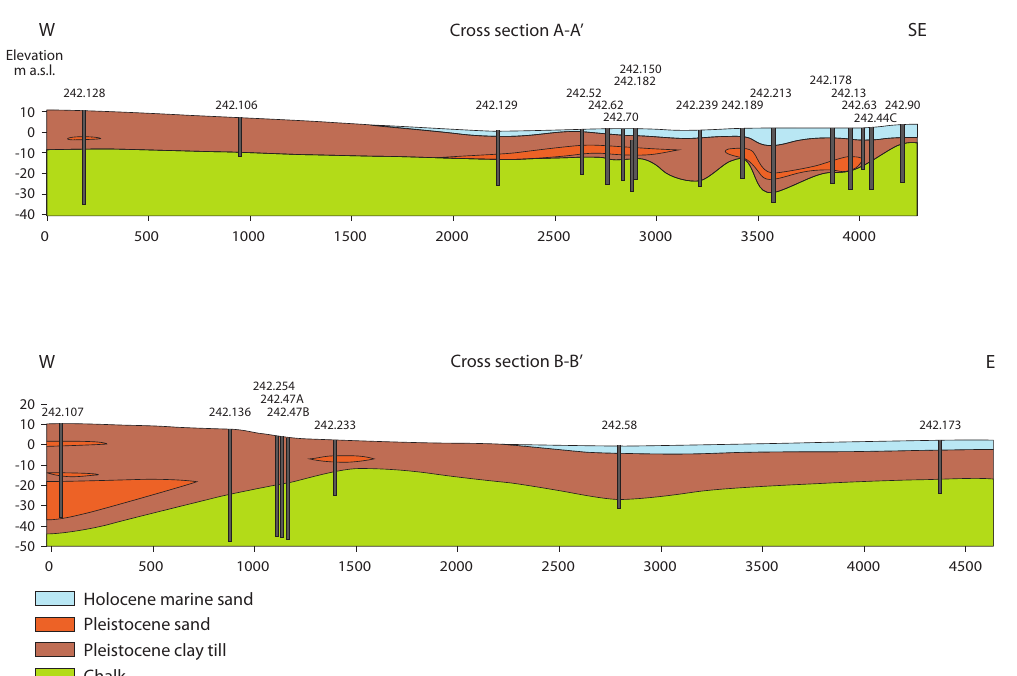
Fig. 3. Cross sections through the area showing the main geological layers, aquifers and aquitards in the established seawater intrusion (SWI)